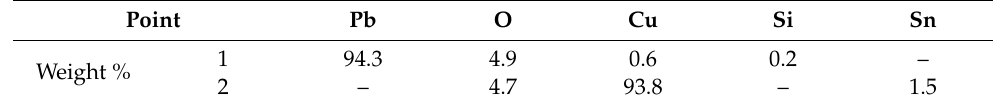
Table 2. The results of the microanalysis in the light and gray